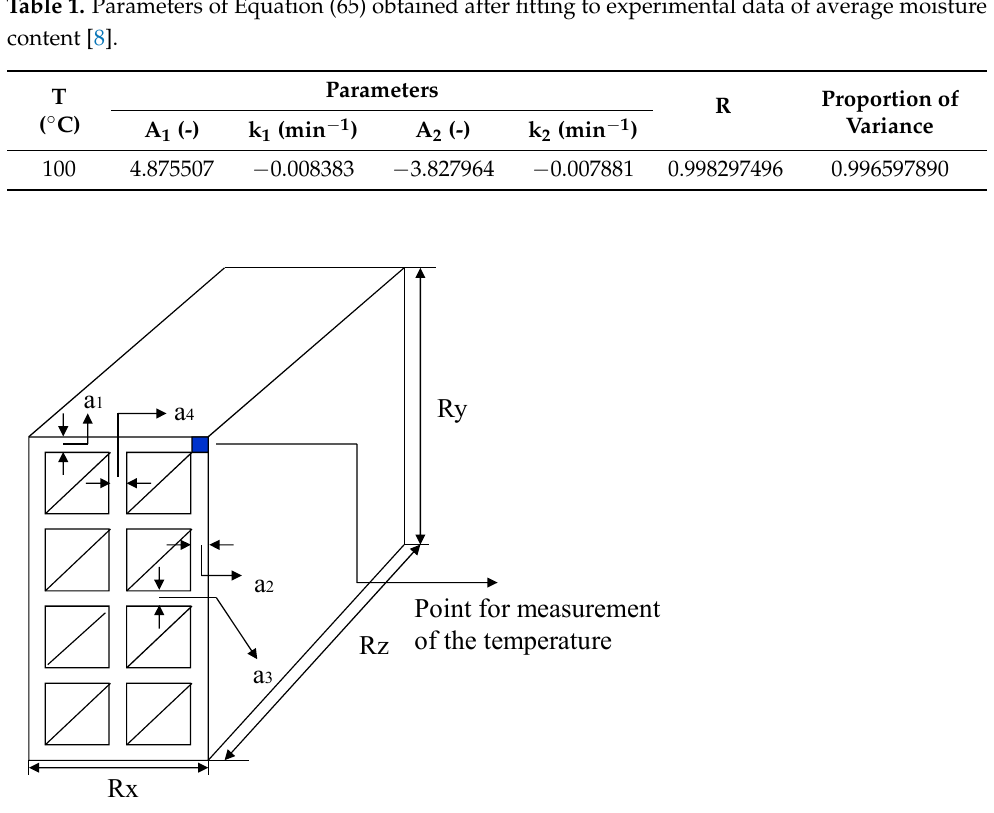
Figure 4. Brick model with the dimensions that characterize the brick and holes, and the location of the brick temperature measurement.